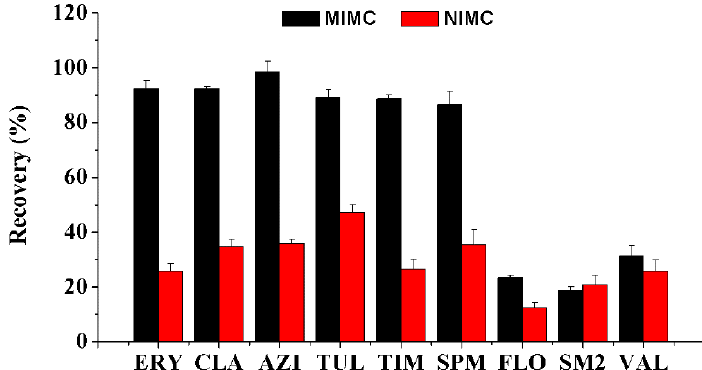
Figure 5. Class-specific adsorption capacities of MIMC and NIMC for six macrolides (same as Figure 4), florfenicol (FLO), sulfadimidine (SM2), and valnemulin (VAL).